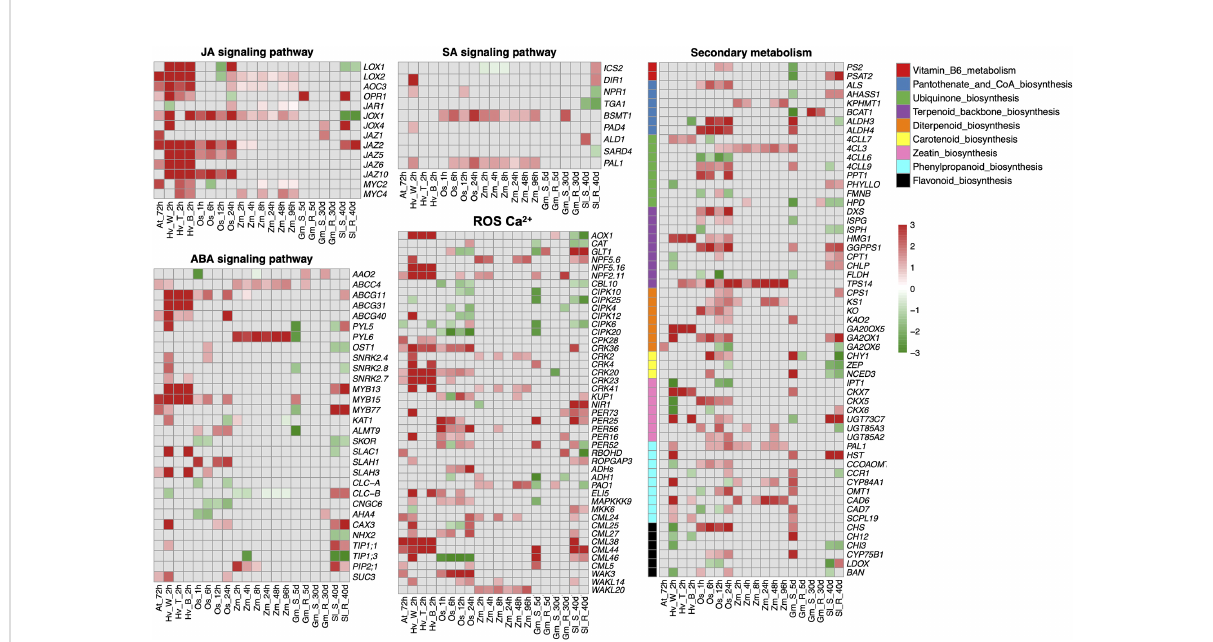
FIGURE 2 Integrative analysis of transcriptomes from different plant species fed by their main herbivores. The differential expressed genes (DEGs) with a threshold (fold change >1, FDR < 0.05) in JA, SA, ABA, ROS, and Ca 2+ signaling pathways and plant secondary metabolisms (PSM) are shown in heatmaps. The color scale represents the fold change value from low (green) to high (red). The row name and column name of each heatmap indicate the gene name and experimental abbreviation, respectively. Abbreviations for experimental codes of plant and insect species can be found in Table 1. JA signaling pathway: LOXs , lipoxygenase; AOCs , allene oxide cyclase; OPRs , oxophytodienoic acid reductases; JAR1 , jasmonate resistant 1; JAZs , jasmonate ZIM domain; MYCs , basic-helix-loop-helix transcription factor. ABA signaling pathway: AAOs , aba- aldehyde oxidase; ABCGs , Arabidopsis thaliana ATP-binding cassette G; PYLs , pyrabactin resistance-like; SnRKs , snf1-related protein protein kinase; MYB , transcription factor in abscisic acid signaling; KATs , guard cell inwardly rectifying K + channel; ALMTs , aluminum-activated malate transporter; SKORs , outward-recti fi er K + channel; SLAC/SLAHs , S-type anion channels; CLC-A/B , chloride channel A/B; CNGCs , cyclic nucleotide-gated channels; AHAs , H + -ATPase; CAXs , cation/H + exchanger; NHXs , sodium hydrogen exchanger; TIPs , tip growth defective; PIPs , plasma membrane intrinsic proteins; SUCs , Sucrose transport protein. SA signaling pathway: ICSs , isochorismate synthase; DIRs , drought- induced ring fi nger; NPRs , non-expressor of pathogenesis-related genes; BSMT1 , BA/SA carboxyl methyltransferase 1; PAD4 , peptidyl arginine deiminase 4; SARD4 , SAR-de fi cient 4; PAL1 , phenylalanine ammonia lyase. ROS, Ca 2+ : AOXs , alcohol oxidase; CATs , catalase; NPFs , nitrate peptide transporter family; CIPKs , CBL-interacting serine/threonine-protein kinase; CRKs , cysteine-rich receptor-like protein kinase; KUPs , potasium ion uptake permease; NIRs , nitrite reductase; RBOHD , respiratory burst oxidase homologous protein D; ROPGAPs , RHO GTPase activating proteins; ADHs , alcohol dehydrogenases; PAOs , polyamine oxidases; MAPKs , mitogen-activated protein kinase; CMLs , calmodulin-like proteins; WAKs , wall-associated receptor kinases. Secondary metabolism: PS2 , phosphate starvation-induced gene 2; PSAT2 , phosphoserine aminotransferase 2; ALS , acetolactate synthase; AHASS1 , acetolactate synthase small subunit 1; KPHMT1 , ketopantoate